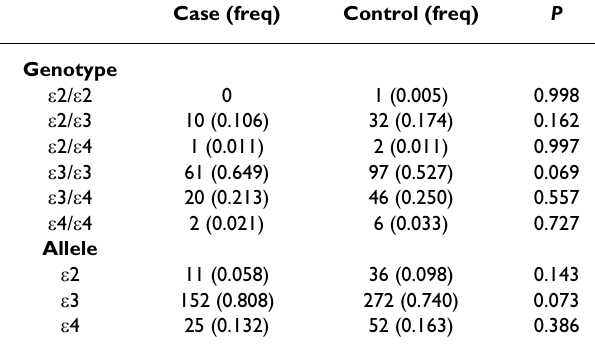
Table 4: Distribution of APOE ε 2/ ε 3/ ε 4 alleles and genotypes Case (freq)